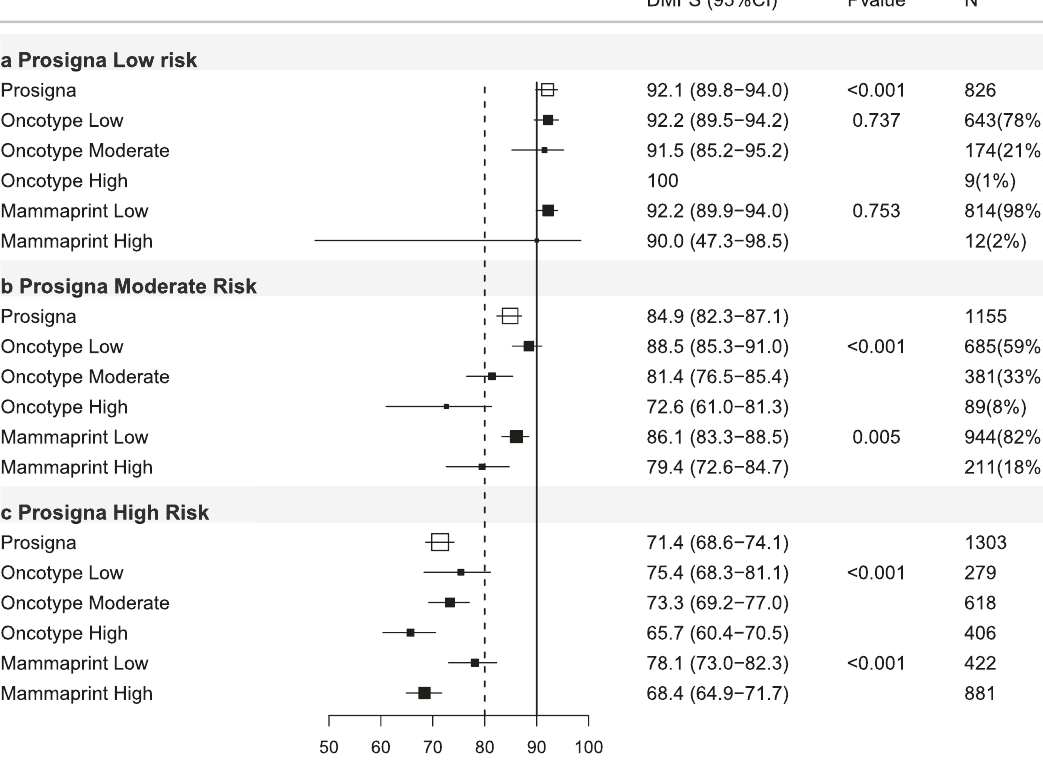
Fig. 3 Forest plot of Prosigna-trained test results re-strati fi ed by other tests, all ER + ve/HER2-ve cases. DMFS10 = distant metastasis free survival at 10 years post diagnosis, (95% CI) = 95% con fi dence interval, P = p value, N = number of cases in each subgroup, % = percentage of cases within each risk strata, X axis = percent distant metastasis free survival. Open boxes represent primary test DMFS10 by risk group. Solid boxes represent sub-strati fi cation by secondary tests with 95% con fi dence intervals (bars). Top panel ( a ) prosigna-trained low risk cases strati fi ed by Oncotype-trained and Mammaprint-trained results. Middle panel ( b ) prosigna-trained moderate-risk group. Bottom panel ( c ) prosigna-trained high risk